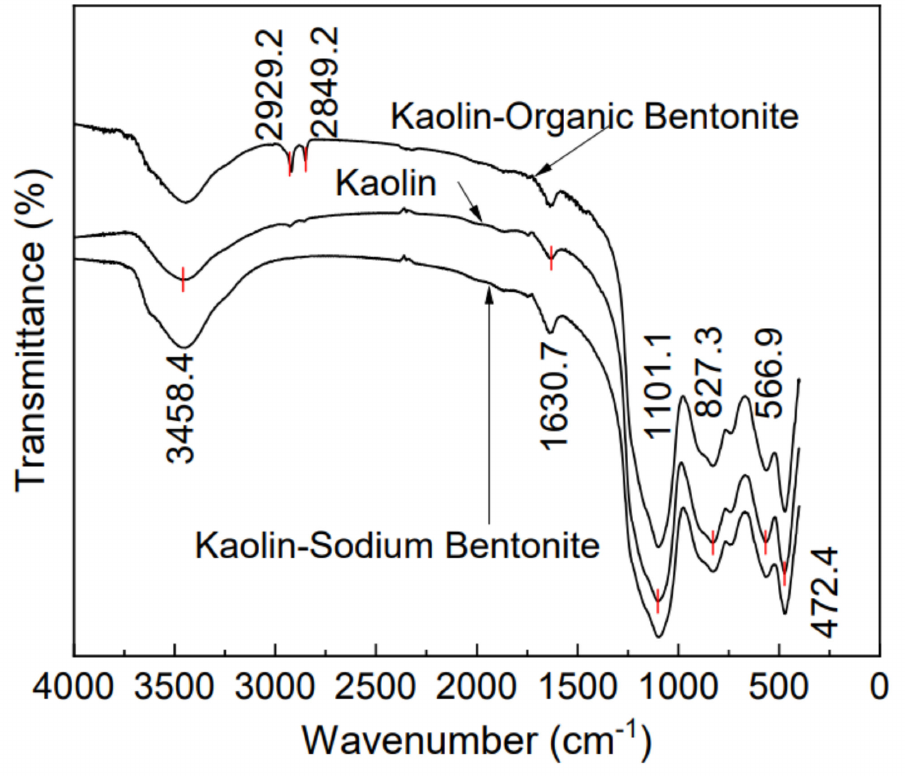
Figure 3. FTIR spectra of the three